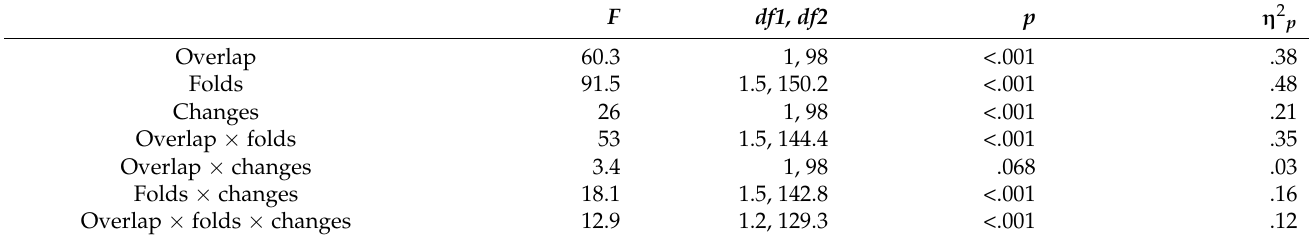
The significant main effect folds was modified by the significant interaction between overlap , folds , and directional changes . This indicated significantly higher error rates with five folds than with four folds, and significantly lower error rates with three folds ( p max = .049), except for one comparison with no overlaps and few changes ( p = .467). The significant main effect directional changes was modified by the significant interaction between folds and directional changes . This indicated that the error rates were significantly higher with more directional changes than with fewer directional changes with three folds ( p max = .031) and five folds ( p max = .018), but not with four folds ( p min = .054). The significant main effect overlap was modified by the significant interaction between overlap , folds , and directional changes . This indicated significantly higher error rates with overlaps than with no overlaps ( p max = .001), except for three folds with one directional change. Furthermore, the significant interaction between folds and overlap indicated that the difference between overlaps was significantly larger with five folds ( ∆ M = 22.9%) than with four folds ( ∆ M = 9.1%, p < .001), and significantly lower with three folds ( ∆ M = 1.4%; p max <